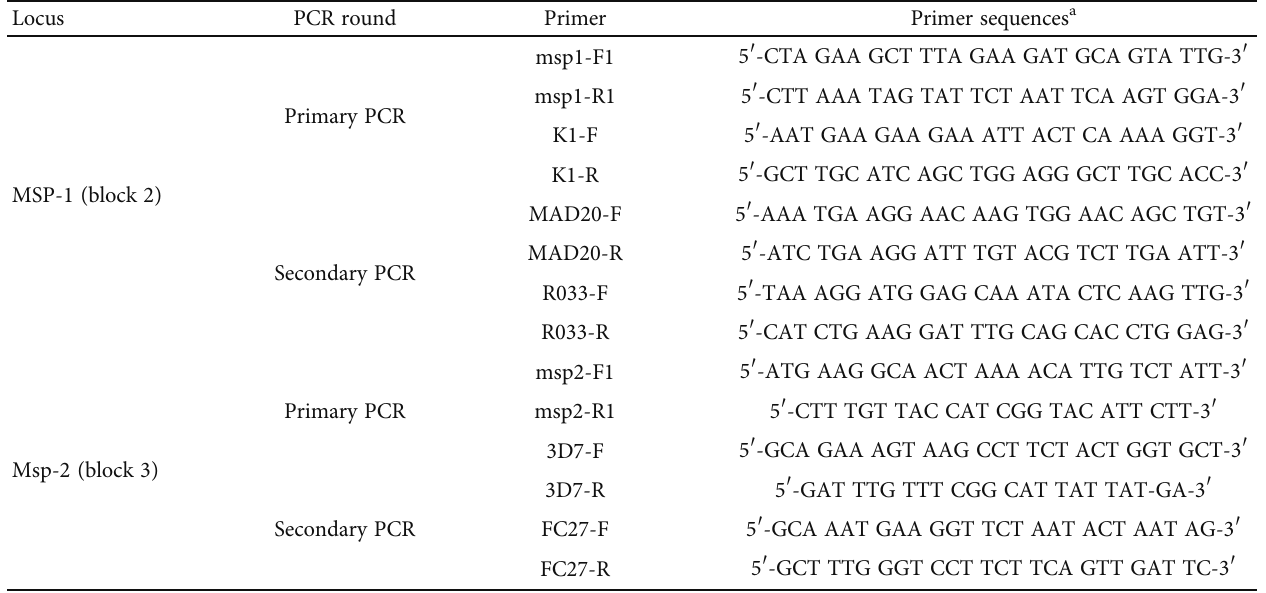
Table 1: Sequences of the primers for msp -1 and msp -2 genes in Plasmodium falciparum isolates.